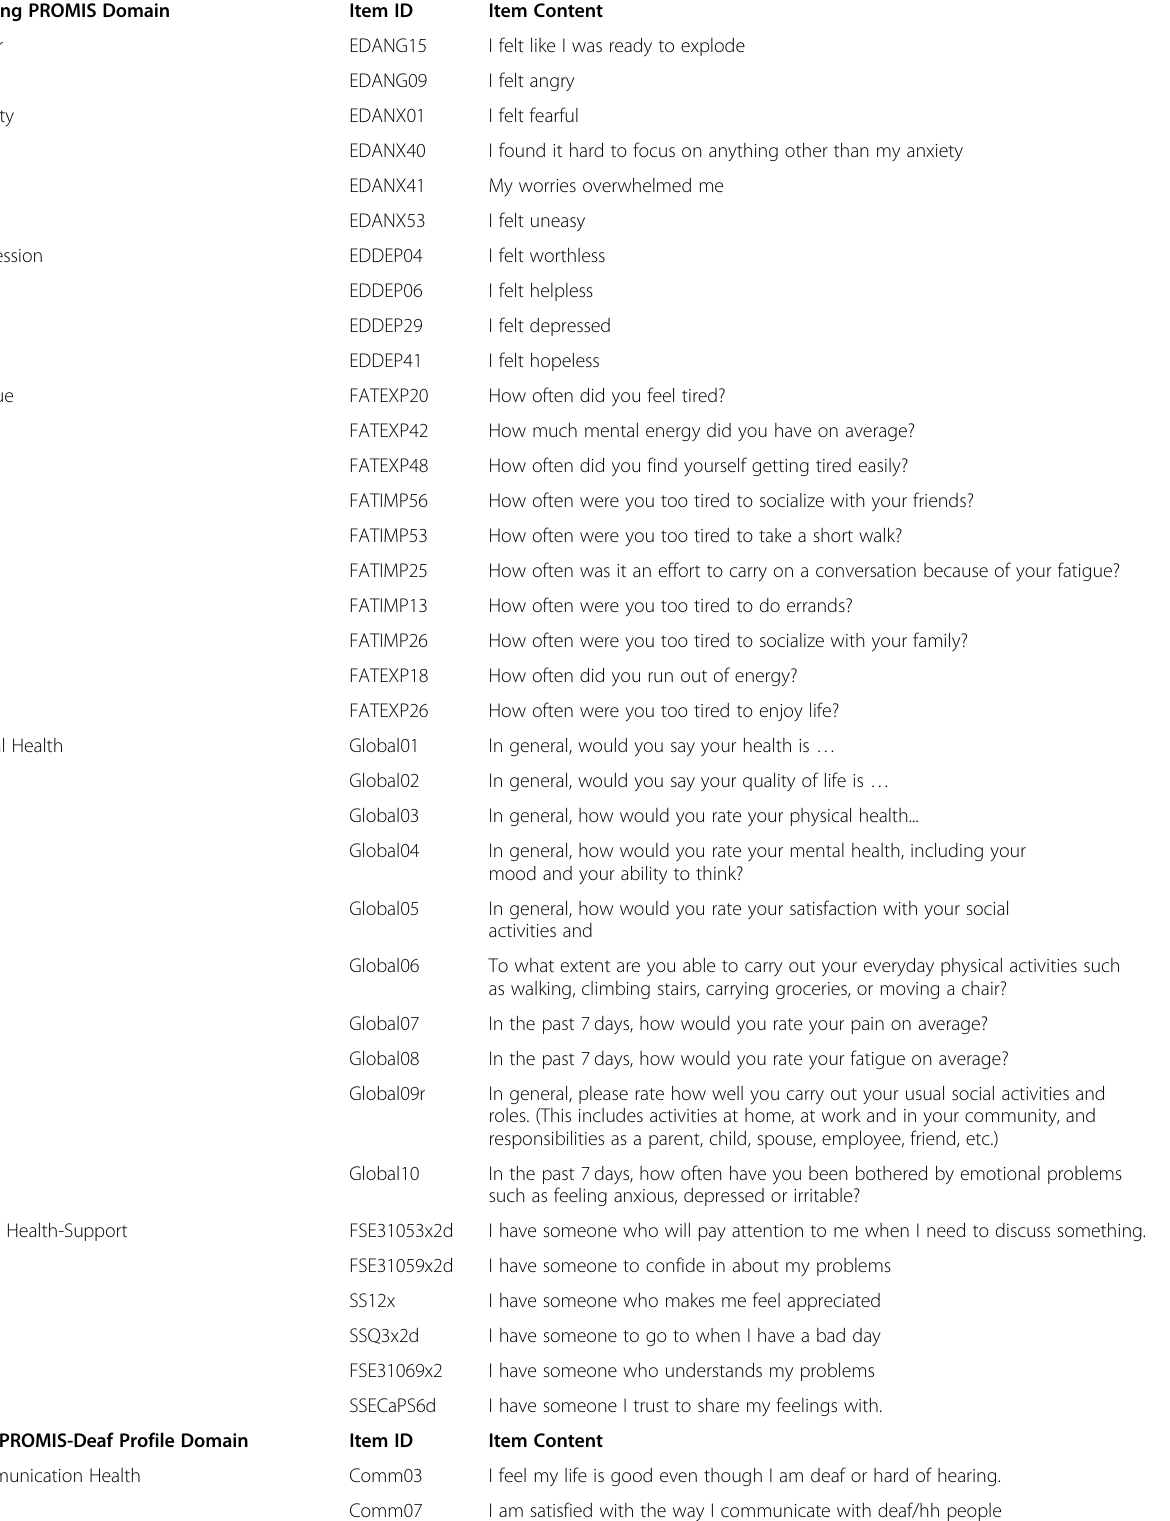
Table 2 Existing and New PROMIS-Deaf Profile Domains and Item